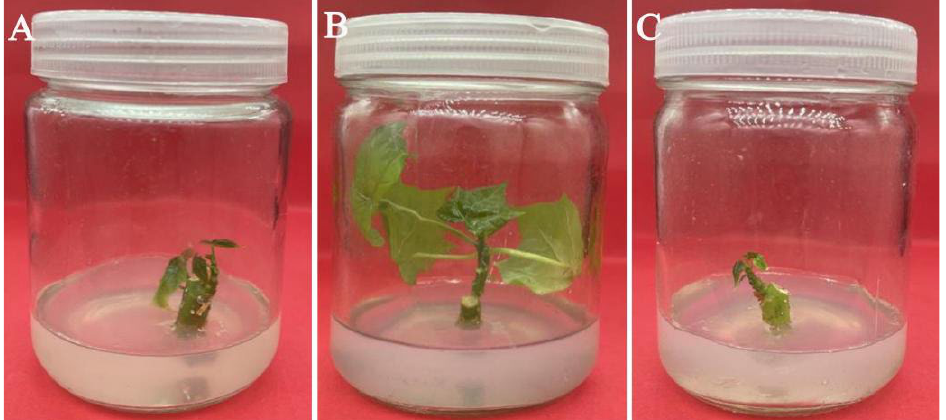
Figure 2. Axillary bud induction of stem segments on different media. ( A ) MS medium supplemented with 0.5 mg/L 6-BA; ( B ) 1/2 MS medium supplemented with 0.5 mg/L 6-BA; and ( C ) B5 medium supplemented with 0.5 mg/L 6-BA. Table 6. Effect of medium type and 6-BA on the mean length of axillary buds (cm).